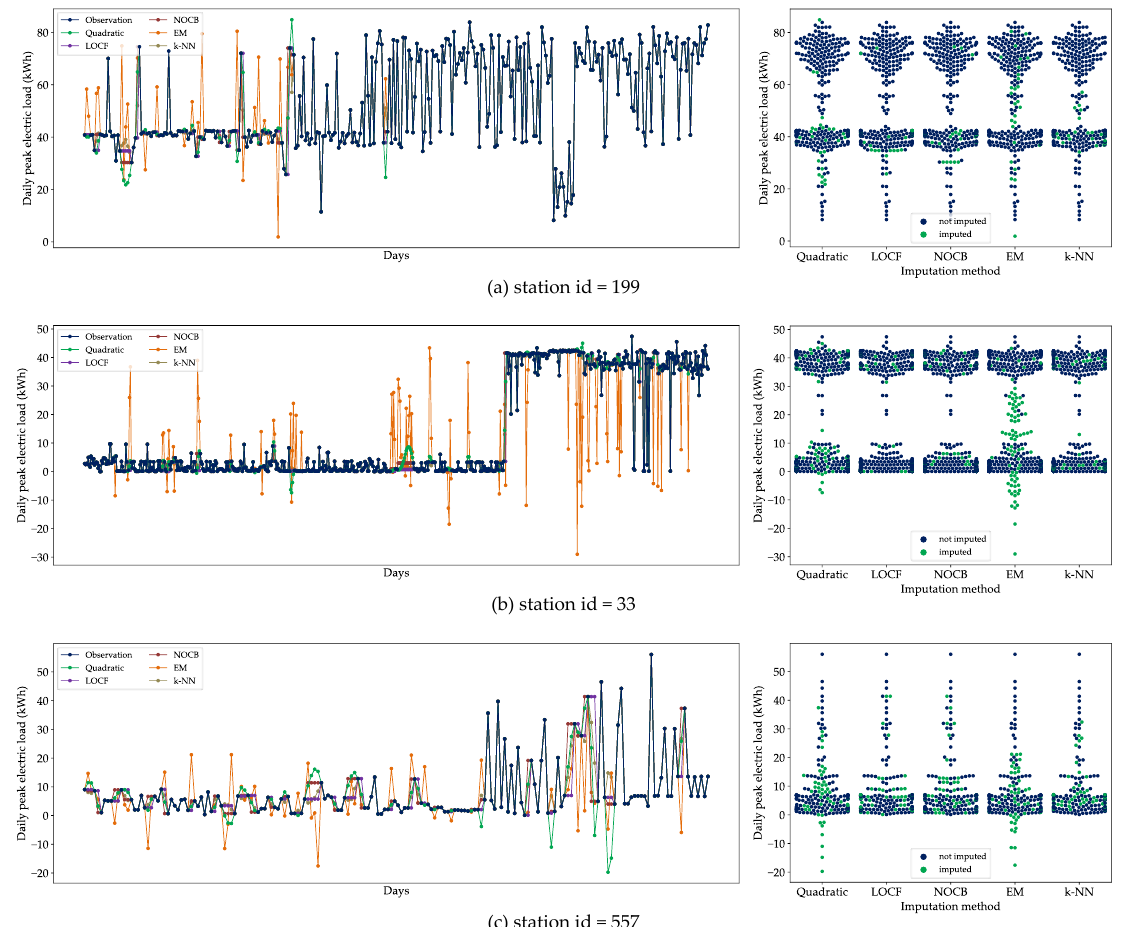
Figure 10. Imputation results in the sample station data.